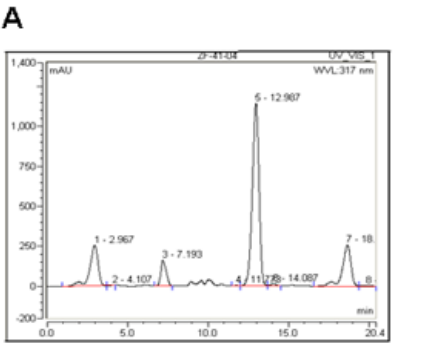
Figure 1. HPLC and the structure of emodin-8- O - β - D -glucoside. (A) HPLC